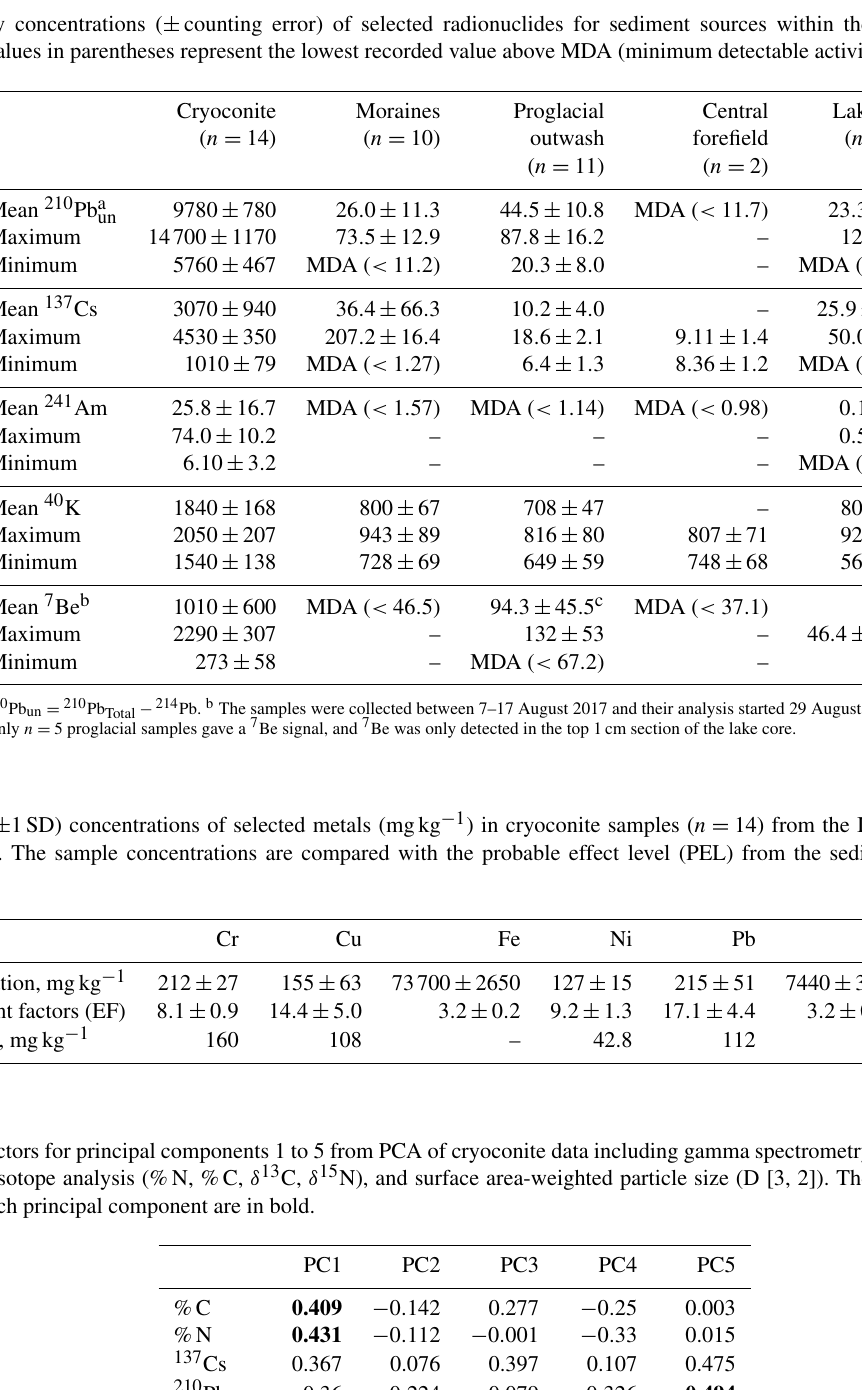
Table A2. Activity concentrations ( ± counting error) of selected radionuclides for sediment sources within the Isfallsglaciären catch- ment (Bqkg − 1 ). Values in parentheses represent the lowest recorded value above MDA (minimum detectable activity).